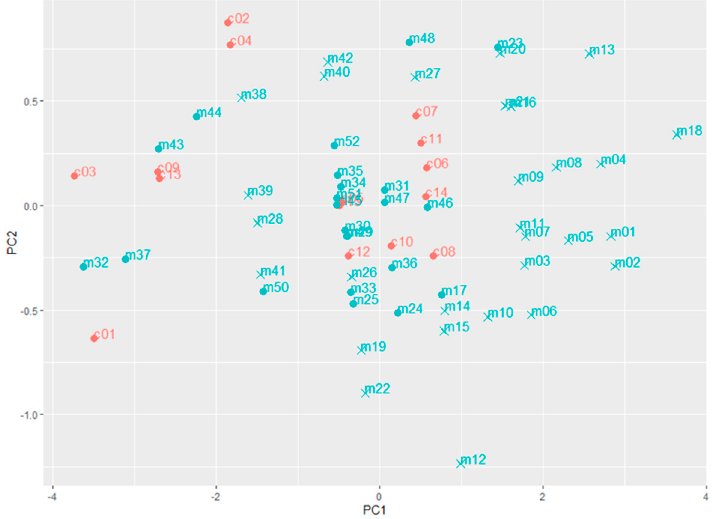
Figure 4. The principal component analysis (PCA) plot of the first two PC dimensions of the control samples (red points) and the market survey samples (blue points) based on the results obtained from the MilkoScan measurements. The suspected samples flagged by the k-nearest neighbours (KNN) model of the measured dataset are cross-shaped (x).